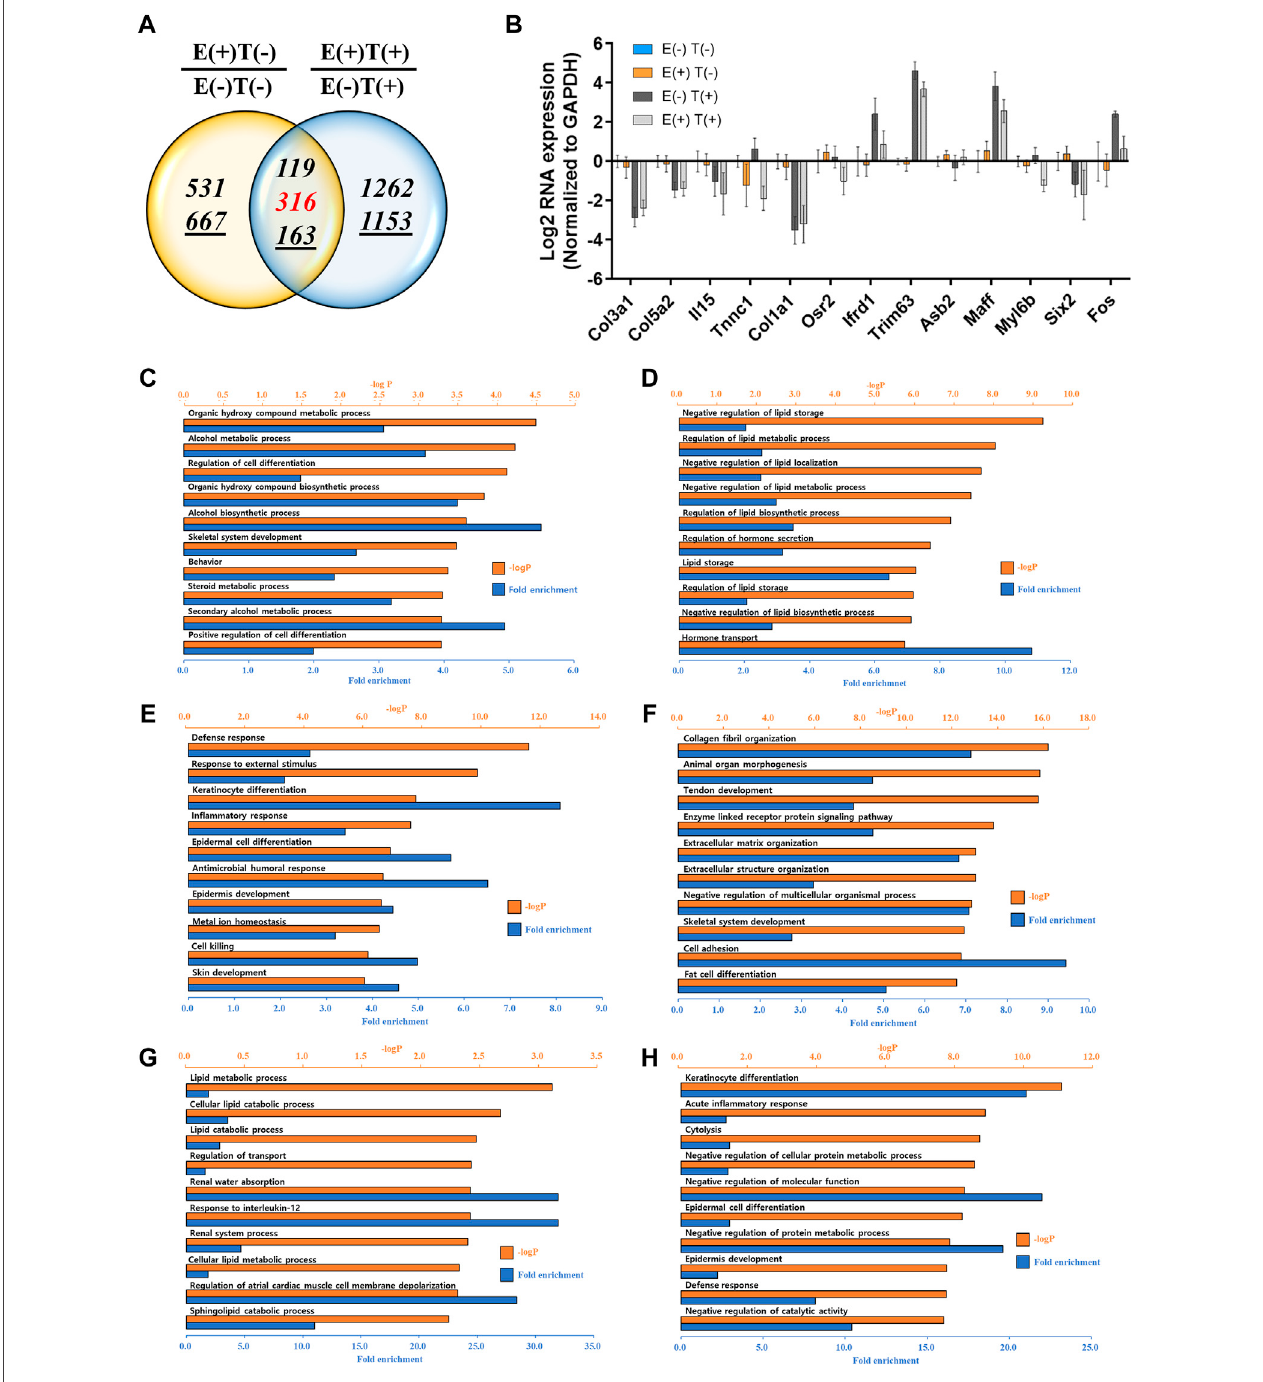
FIGURE 3 | mRNA-seq analysis of skeletal (gastrocnemius) muscle tissue. (A) Venn diagram of the number of DEGs for the effect of exercise for normal [E(+)T( − )/ E( − )T( − )] and tumor-bearing [E(+)T(+)/E( − )T(+)] mice. The high-intensity aerobic exercise resulted in 1,796 up- or downregulated genes by at least two-fold, while tumor- bearing mice resulted in a change in the 3,013 genetic expressions by at least two-fold. The italicized number indicates the number of upregulated genes while the italicizedandunderlinednumberindicatesthenumberofdownregulatedgenes.Thosewithoppositeeffectsbetweenthetwogroups(contra-regulated)areshown inred.TheDEGswerede fi nedasgeneswithafoldchangeoftwoandanormalized readcountoffour. (B) Bargraphoflog2foldchangeofselectedgenesinthecontra- regulated group using RT-qPCR of the littermates. The fold change was calculated by normalizing the data to that of the housekeeping gene (glyceraldehyde 3- phosphate dehydrogenase , GAPDH ) and then to the level in the normal control group. A consistent change compared to the mRNA-seq analysis was observed. (C,D) GO analysis of the upregulated (C) or downregulated DEGs (D) comparing E(+)T( − ) and E( − )T( − ) mice. The signi fi cant enriched terms include biosynthetic hormone